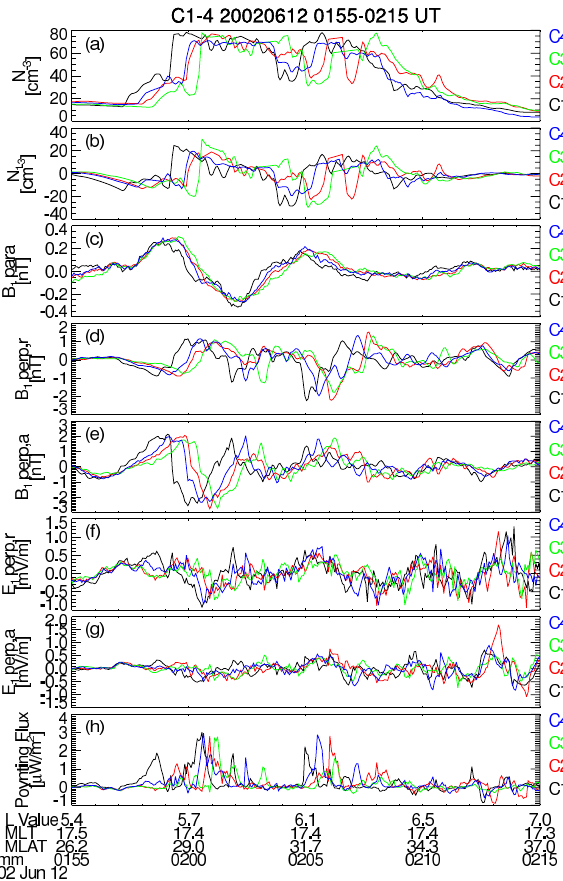
Fig. 6. Data from all Cluster spacecraft during the outbound plume crossing from 01:55 to 02:15UT on 12 June 2002. The figure shows (a) the number density, (b) its fluctuations, (c) – (e) three compo- nents of magnetic fluctuations, (f) – (g) two perpendicular compo- nents of electric fluctuations, and (h) Poynting flux along the mag- netic field. Spacecraft locations are noted in the bottom of the